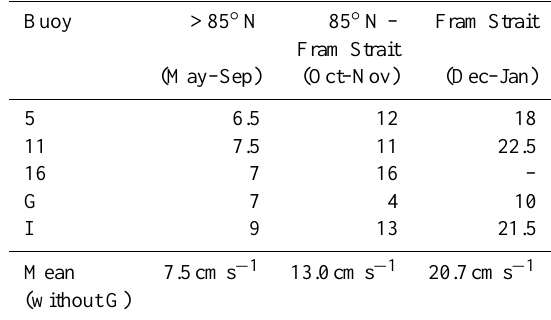
Table 1. Median values of drift speed in cms − 1 for five buoys in different regions of the transpolar drift